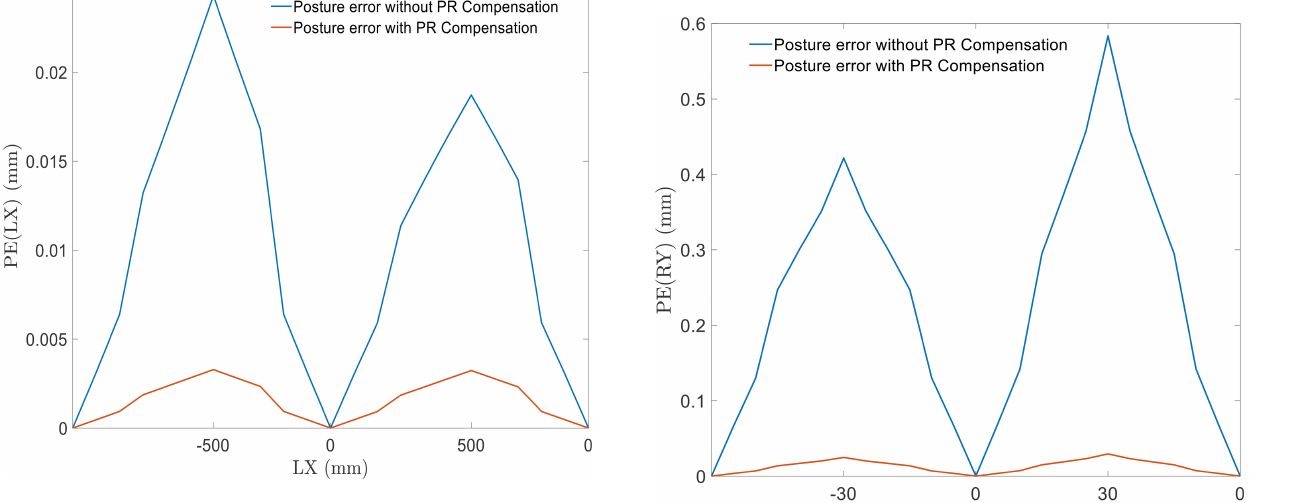
Figure 7. Comparison of posture errors in linear motion along x di- rection.